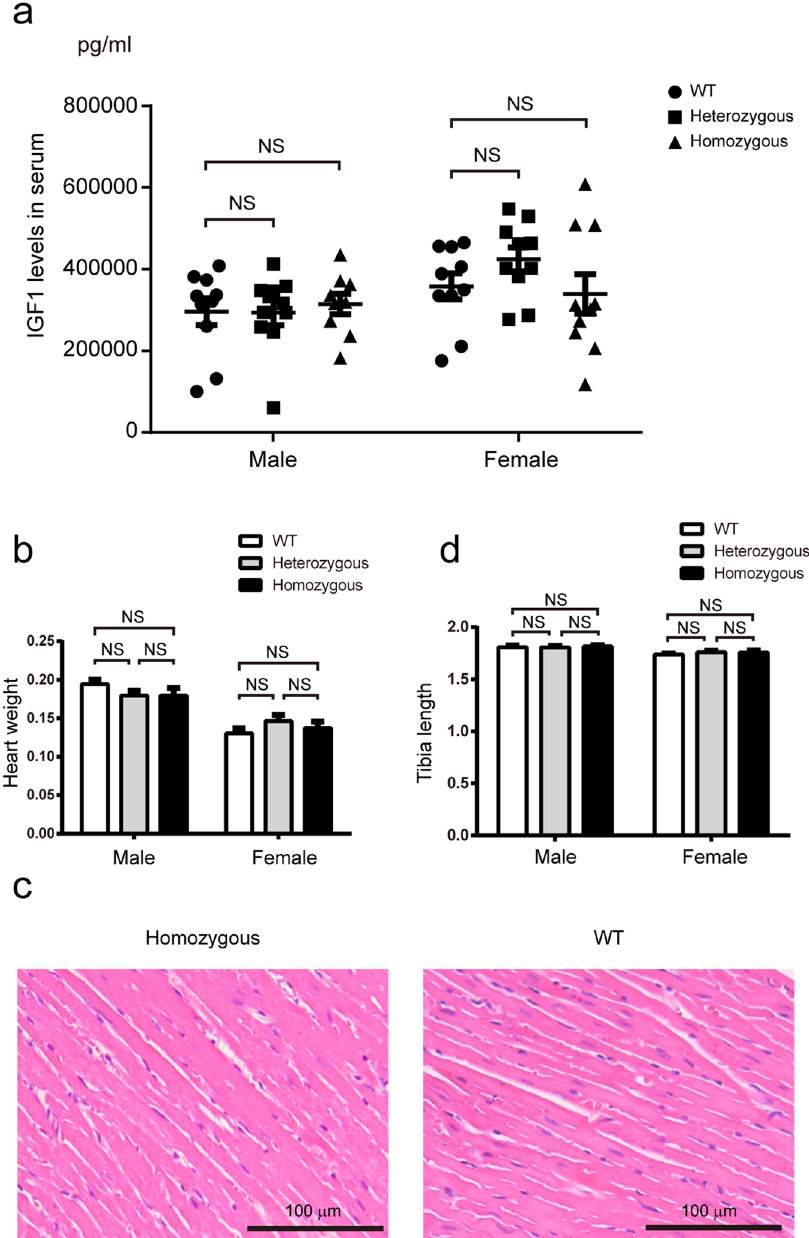
Figure 7. Evaluation of the systemic effect of elevated IGF1 in skeletal muscle. (a) ELISA analysis of the total IGF1 levels in serum from two-month-old GM mice and WT littermates (n = 9–10 per group). (b) Determination of the weight of the heart from three-month-old GM mice and WT littermates (n = 7–13 per group). (c) No pathological changes were detected by H&E analysis of the longitudinal section of hearts from three-month old GM mice and WT littermates. (d) Comparison of the tibia lengths of three-month-old GM mice and WT littermates. (n = 8–15 per group). Bars depict mean values, and error bars represent SEM. NS, not significant. Statistical significances were analysed by Student’s